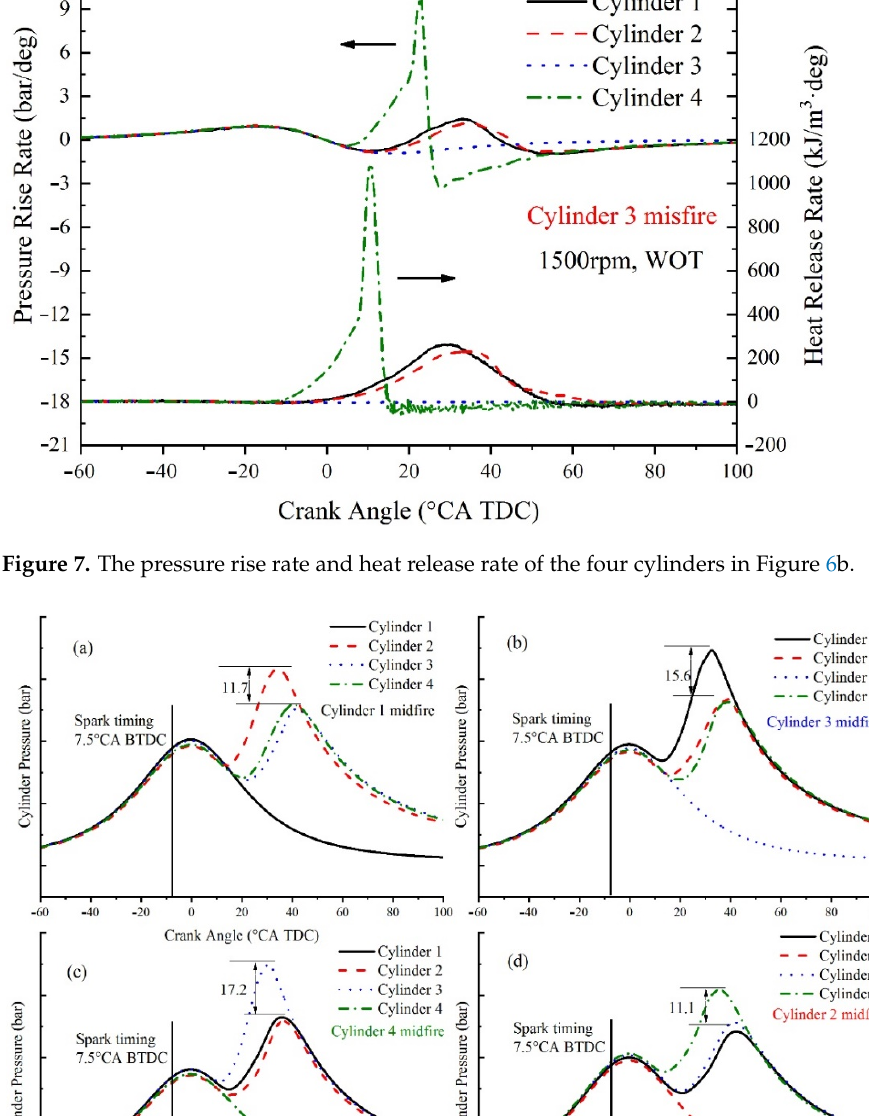
Figure 7. The pressure rise rate and heat release rate of the four cylinders in Figure 6b.